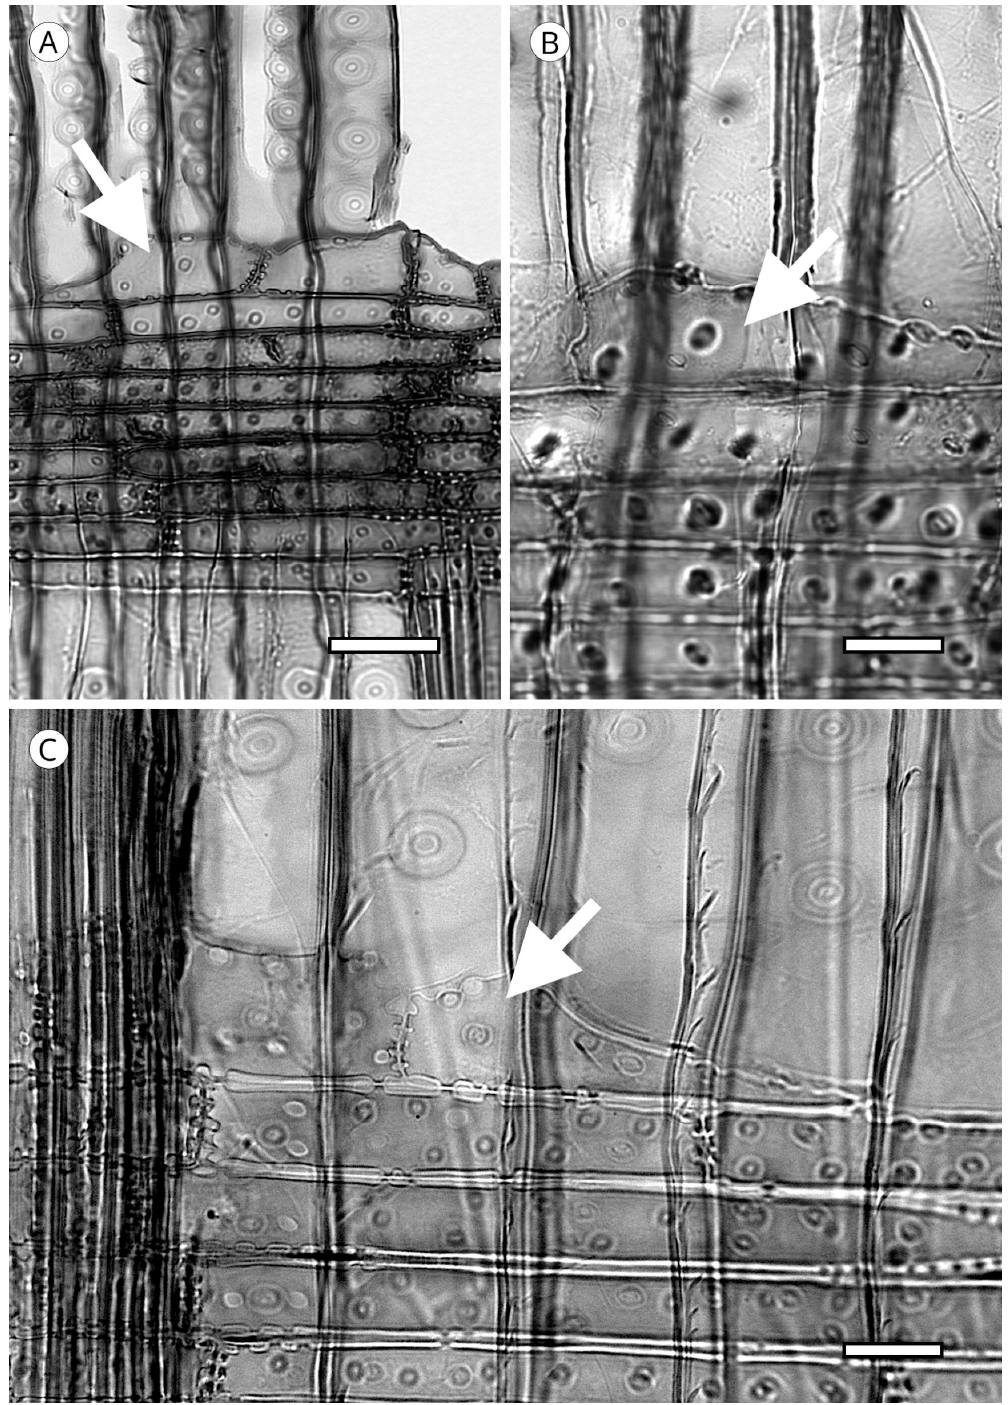
Figure 35. Irregular parenchyma cells in the marginal rows of the rays. ( A ) Abies fraseri (Pursh) Poir.;